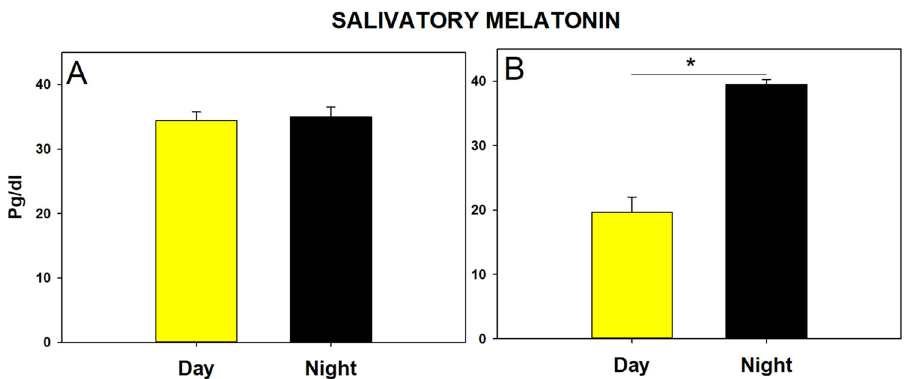
Figure 2. Average salivary melatonin levels; ( A ) For subjects allocated to the CBL group, there is no difference in average melatonin during light and darkness phases. ( B ) Subjects allocated to the LDC had a statistically significant difference in terms of average melatonin during day and night sample acquisition, this difference was identified since day 6 post-birth ( p < 0·0001).